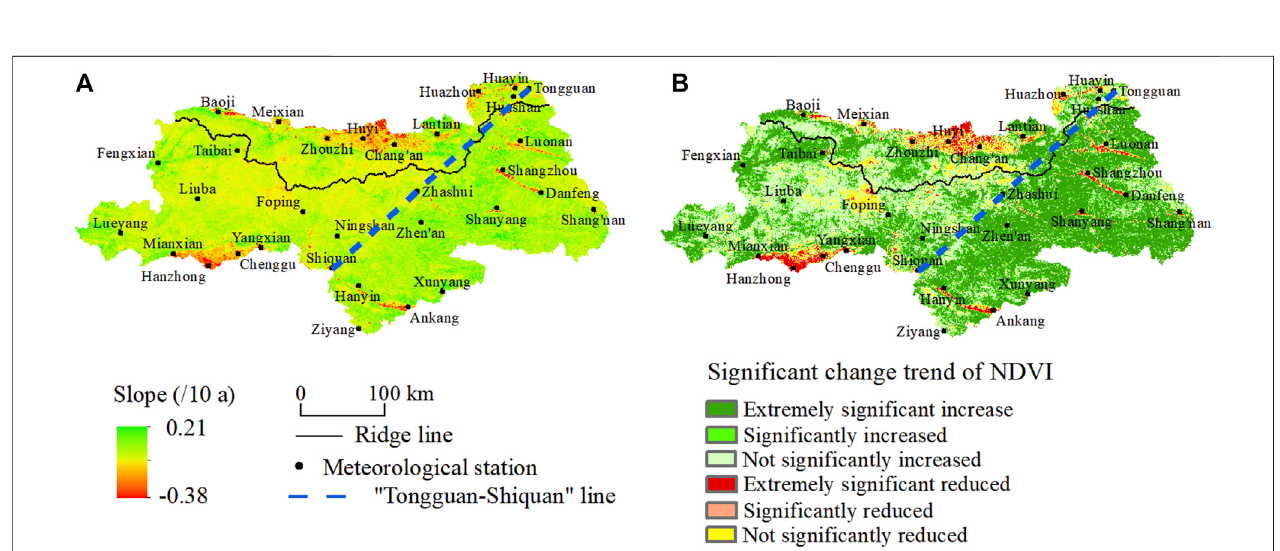
FIGURE 3 | Spatial distribution of trend and the signi fi cance for NDVI in the NSQM and SSQM during 2000 – 2019.